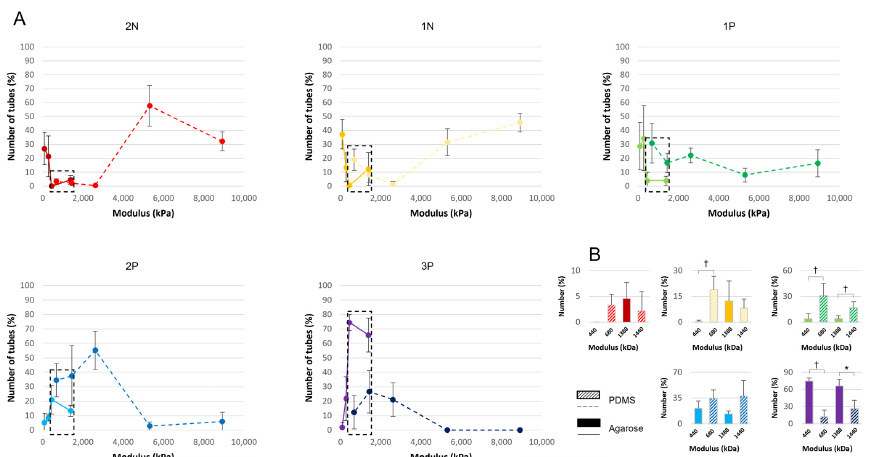
Figure 5. ( A ) Number of each tube stages (from 2N to 3P) in function of the Young’s modulus cul ‐ tured on agarose ( plain line ) or PDMS ( dotted line ). ( B ) Close ‐ up of the percentage of tube for ‐ mation in the function of overlapping Young’s modulus from agarose and PDMS substrates. Over ‐ lap areas are indicated by rectangles with dashed lines in ( A ). Symbols indicate p < 0.05 (*) and p < 0.005 (†).